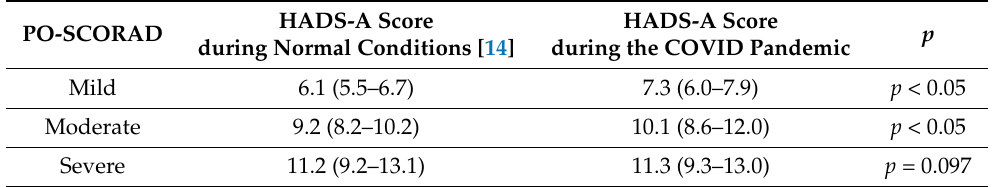
Table 1. Diagnosis of anxiety during COVID-19 compared to the scores during normal conditions. PO-SCORAD